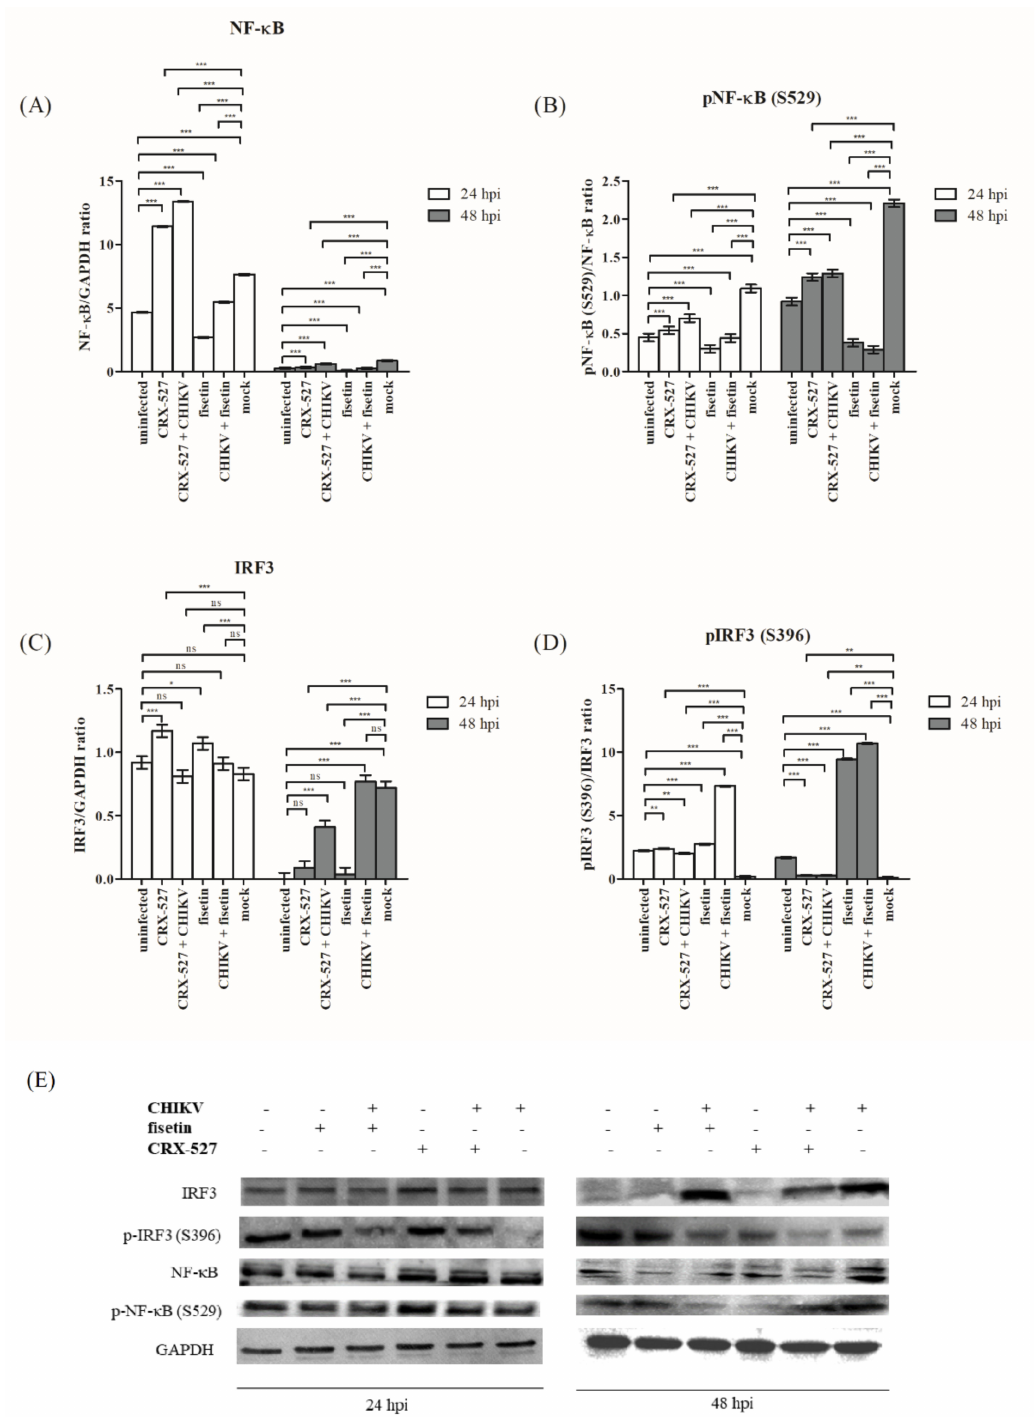
Figure 6. The expression of the transcription factors in the TLR4 pathway. Both ( A ) NF- κ B and ( C ) IRF3 are analyzed relative to GAPDH, while ( B ) pNF- κ B (S529) is relative to NF- κ B expression, and ( D ) pIRF3 (S396) relative to IRF3. The blots were as in ( E ). CHIKV infection was performed using MOI = 1. Data are representative of triplicates and values are expressed as mean ± SD. One-way ANOVA ( p < 0.0001) and Dunnett multiple comparison post-test (* is p < 0.05, ** is p < 0.01 and *** is p < 0.001) were performed by setting uninfected and mock Huh7 cells of respective time point as an independent